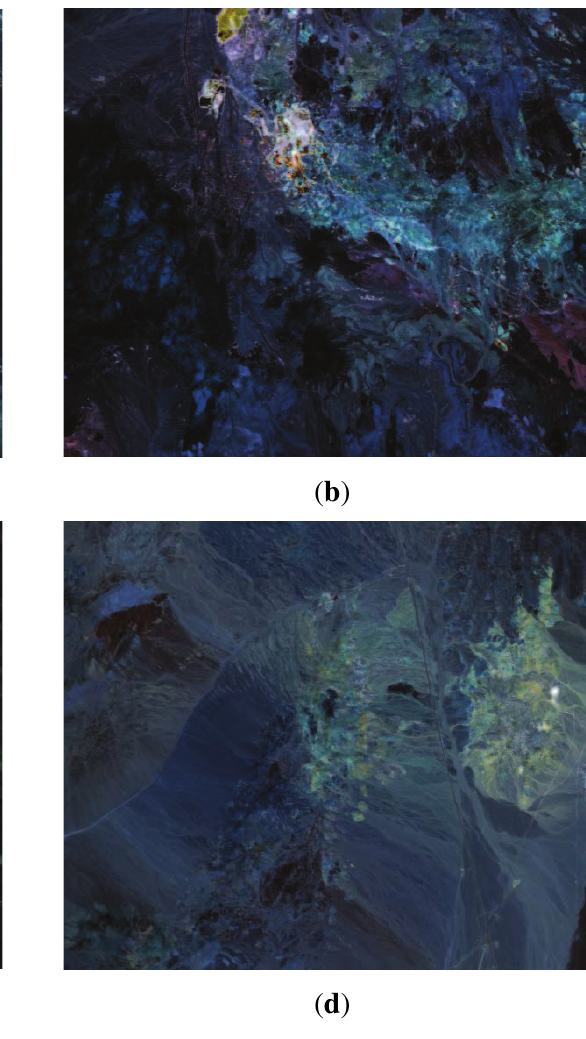
Figure 10. Visualization results with our proposed PDADVS: ( a ) Lun.lake Cuprite ; ( c ) Cuprite ; and ( d ) Cuprite 02 03